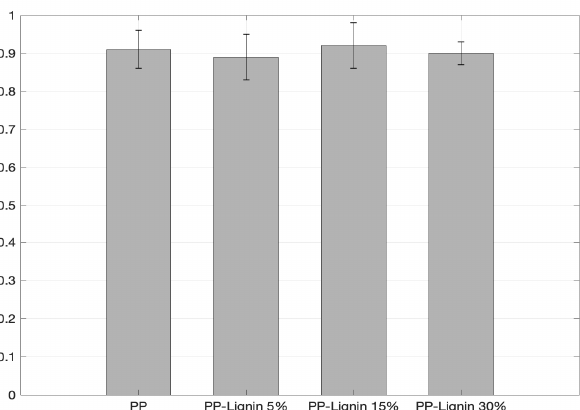
Figure 8 . Shore D hardness values of lignin blends . 3.6. Tensile Properties The tensile properties of PP and lignin blends are shown in Table 4. Figure 9 com- pares the change in UTS as lignin wt. % is increased in PP-lignin blends. With an increase in 5 wt. %, 15 wt. %, and 30 wt. % of lignin, a drop of 3.2%, 9.9% and 5.4% in tensile strength was observed, respectively. Statistically, the values are within the standard devi- ation, and it can be stated that tensile strength seems to be unaffected by the addition of lignin. While a similar trend was observed with Young’s modulus, an exception in behav- ior was observed at 30% wt. lignin concentration, with a 20% increase in stiffness. The 30% wt. lignin blend samples also exhibited a brittle failure, unlike other samples. The varia- tion in stiffness properties is very similar to ShoreD hardness values.